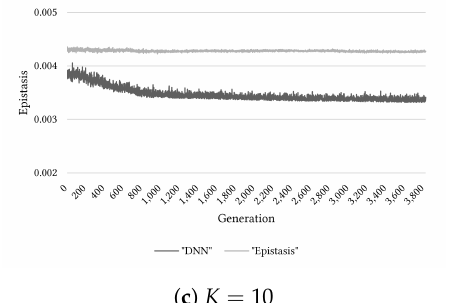
Figure 10. Comparison of target epistasis values (“Epistasis”) and ones estimated by DNN (“DNN”) on the NK -landscape problem ( N = 20).